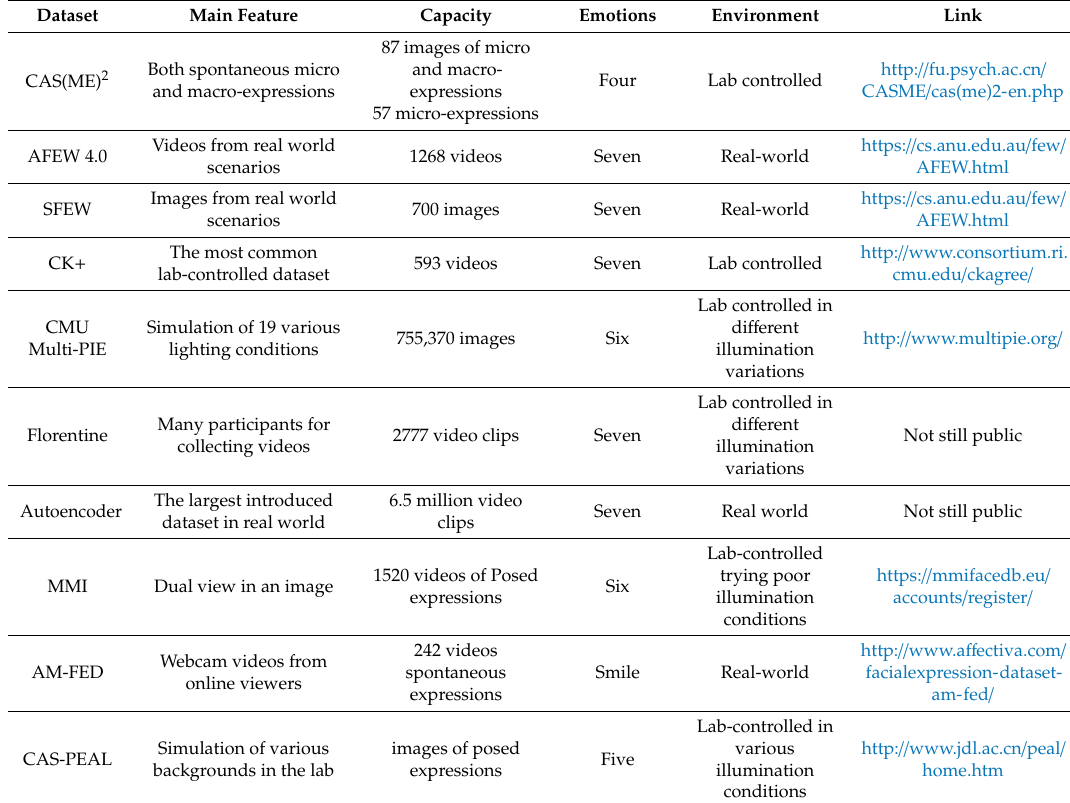
Table 6. The camera-based datasets (under real-world and simulation of real-world conditions in the